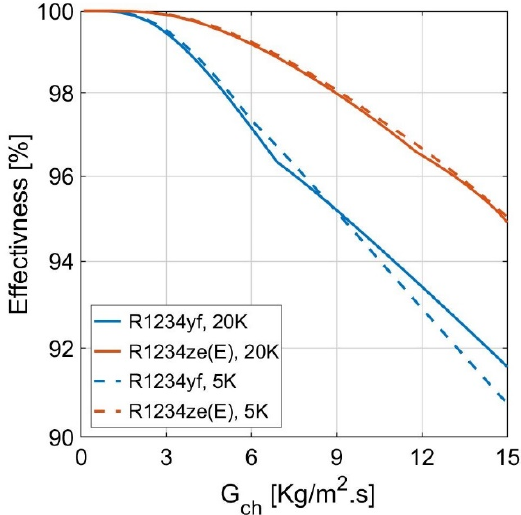
Figure 13. Effectiveness at various cold channel mass fluxes and different superheating tempera- tures.